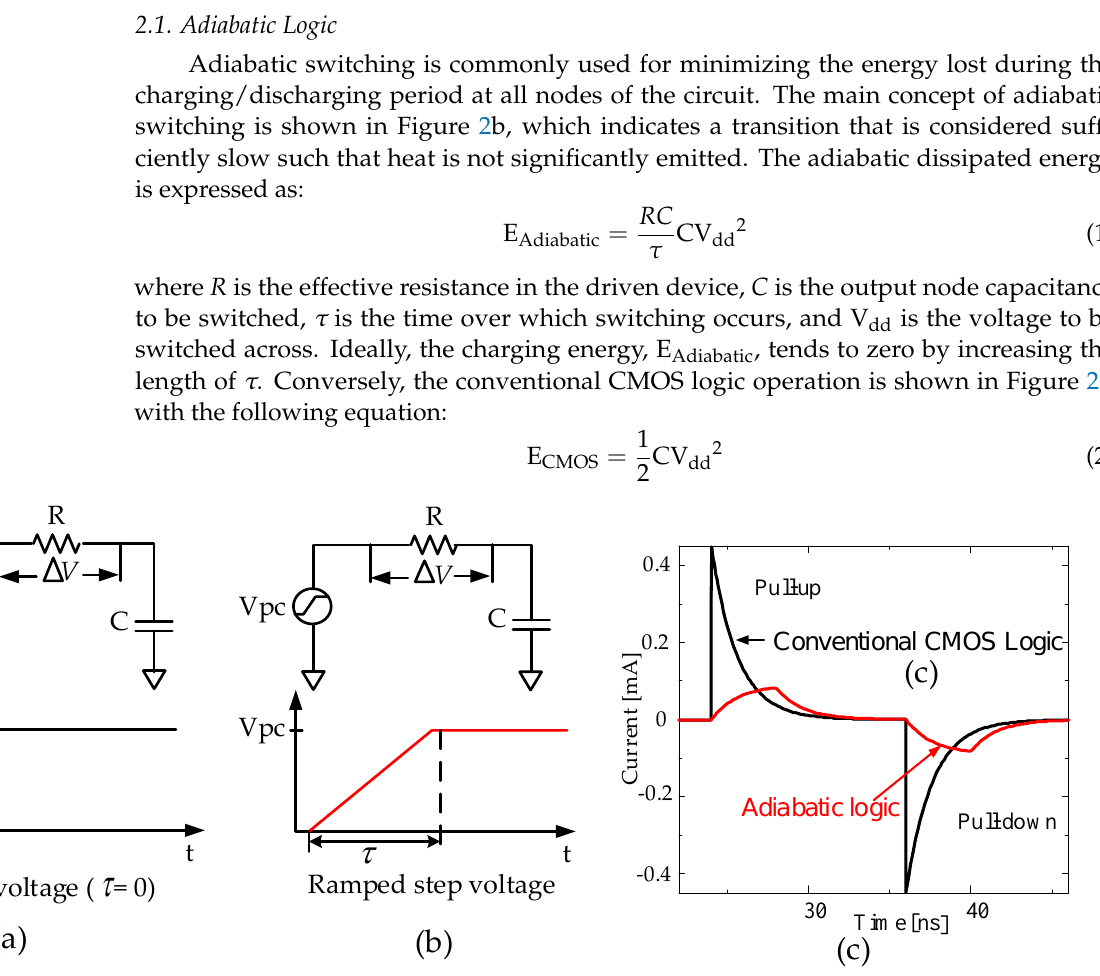
Figure 2. Comparison of the supply currents for the equivalent RC models: ( a ) CMOS logic with step voltage, ( b ) adiabatic logic with ramped step voltage, and ( c ) the peak supply current of the adiabatic logic is significantly lower than that of the conventional CMOS logic under the same parameters and conditions.